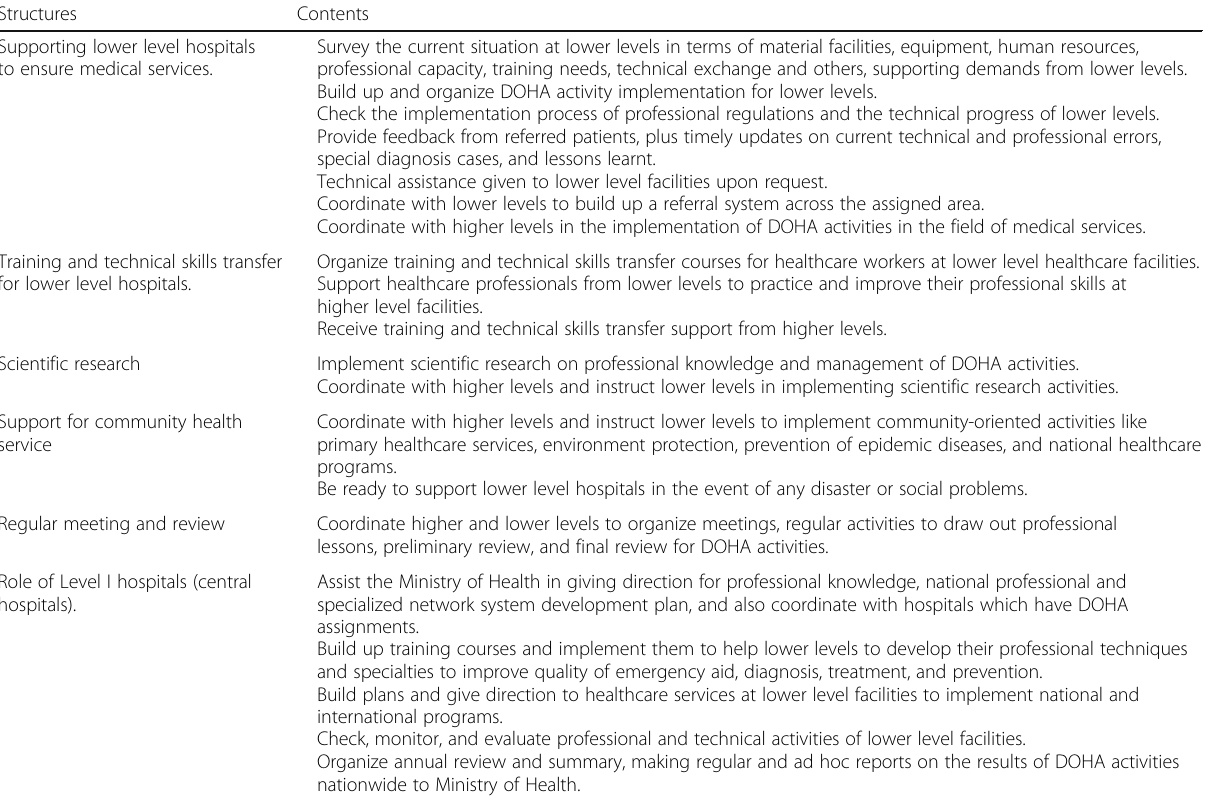
Table 1 Contents of DOHA based on the Decision 4026/QD-BYT by the Ministry of Health, Vietnam (2010)